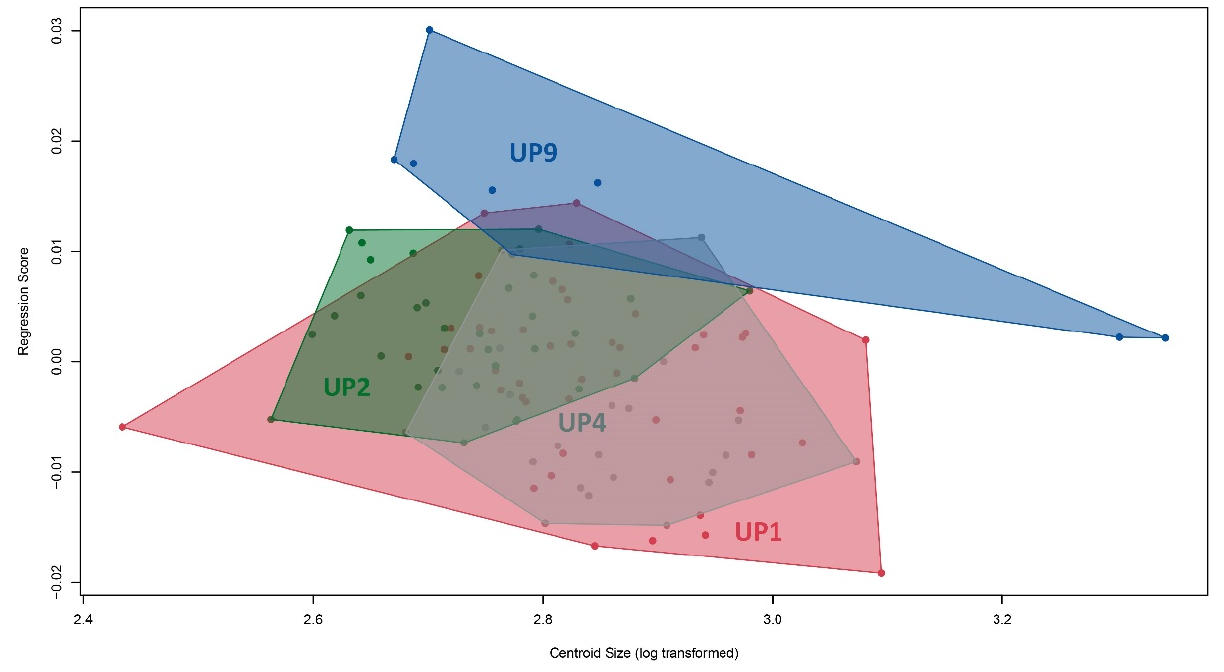
Figure 5. Multivariate regression between body shape and centroid size of C. kraussii. Colors represent localities: red: UEP1; green: UEP2; grey: UEP4; blue: UEP9.